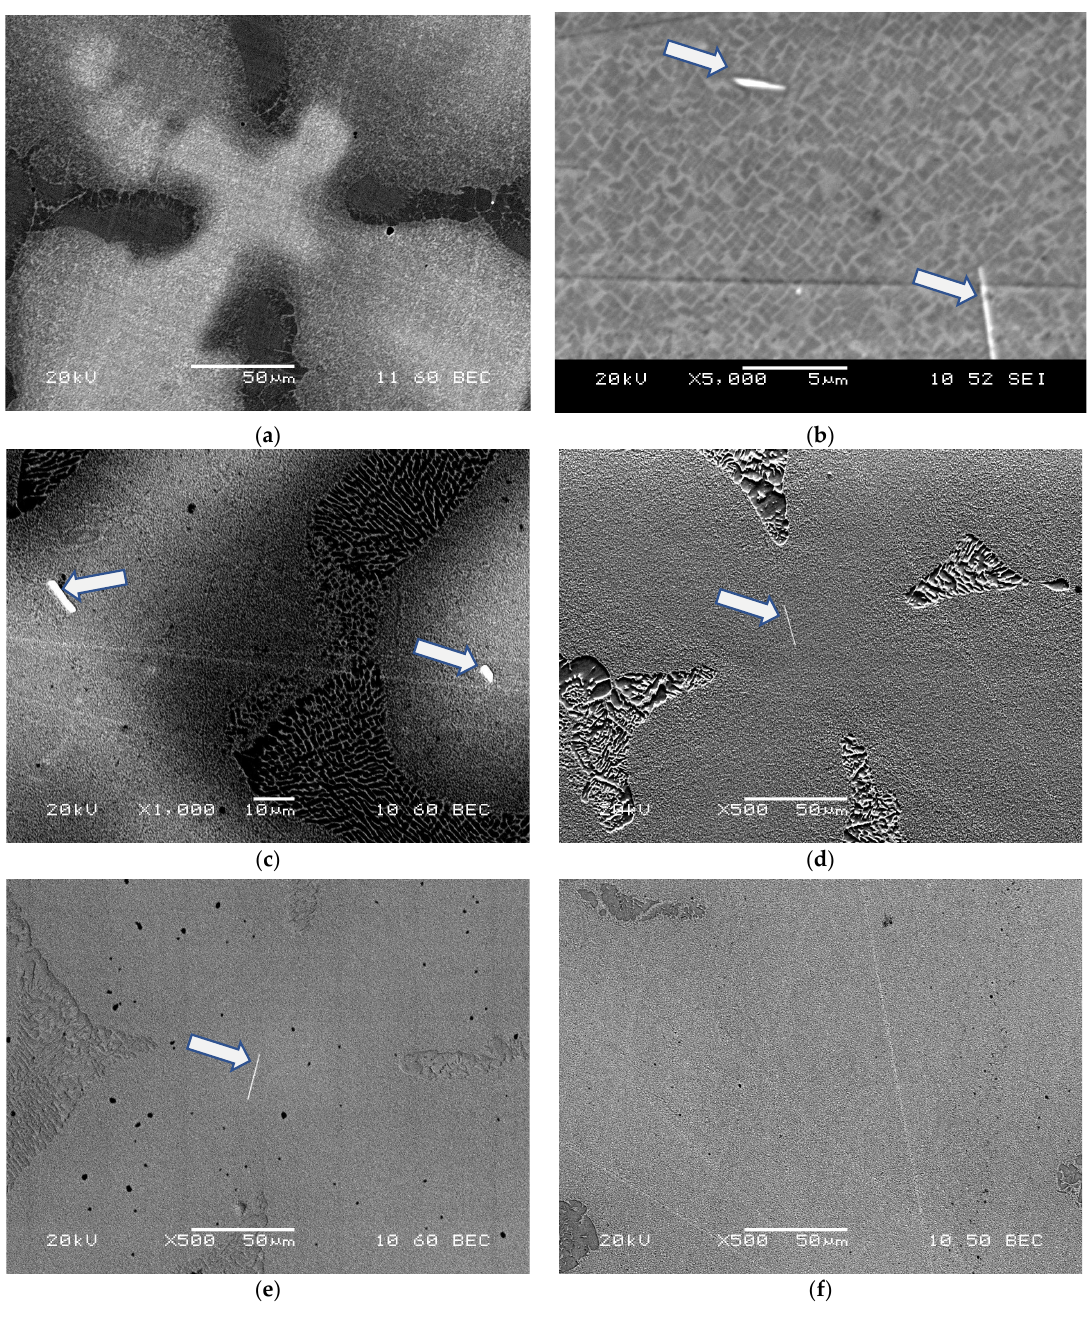
Figure 2. The microstructure of the dendritic cores of samples of different solution times: as-cast ( a ), 0 h ( b ), 1 h ( c ), 4 h ( d ), 8 h ( e ), and 24 h ( f ). TCPs are indicated by arrows.